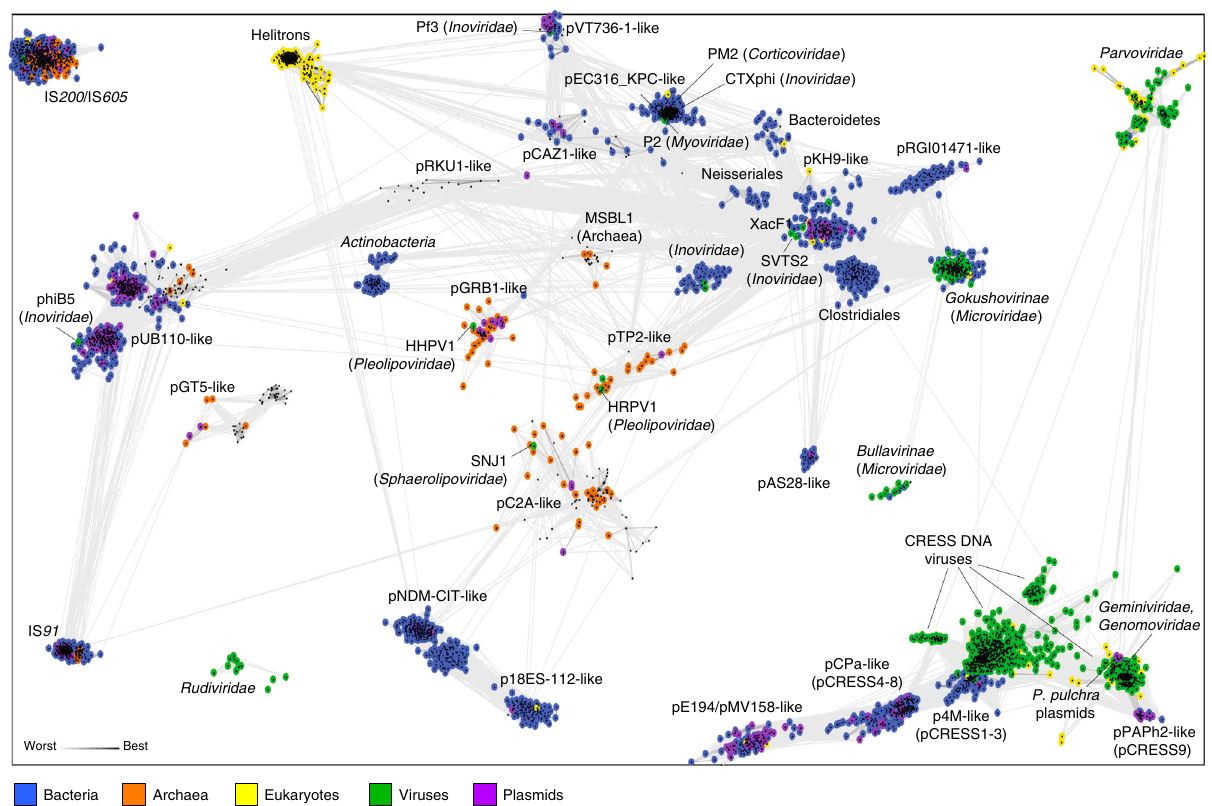
Fig. 1 Representative HUH superfamily Reps clustered by their pairwise sequence similarity. Lines connect sequences with P -value ≤ 1e − 08. Groups were named after well-characterized plasmids, viruses or most frequent